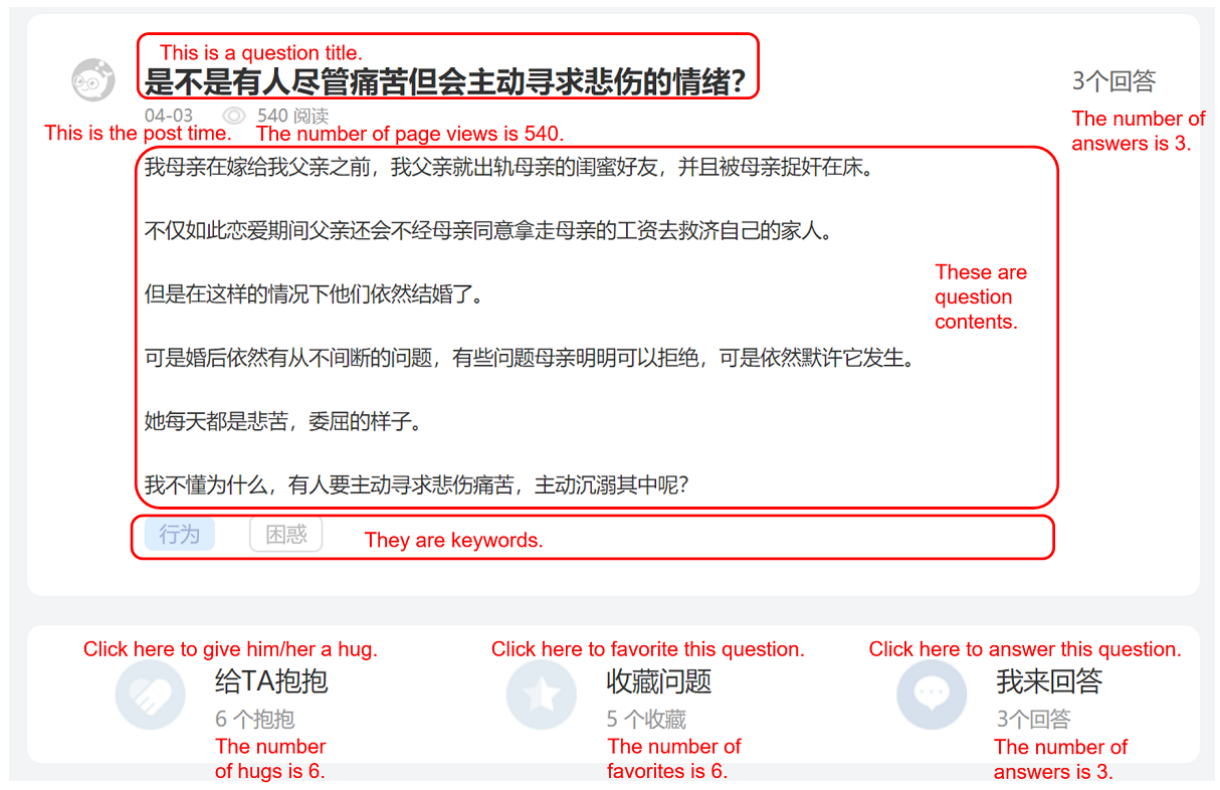
Figure 2. A sample of a